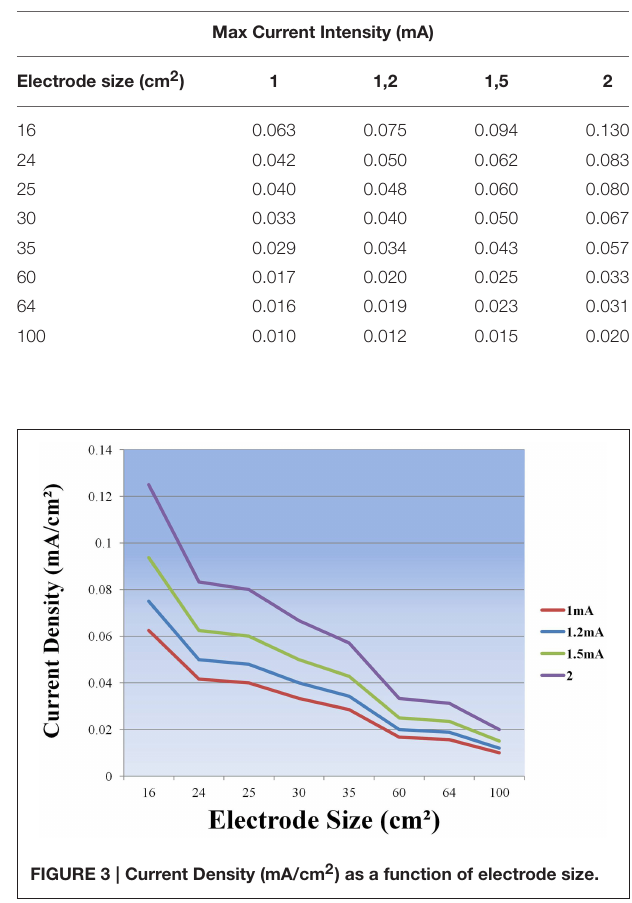
TABLE 3 | Current Density (mA/cm 2 ) of different electrode dimensions.